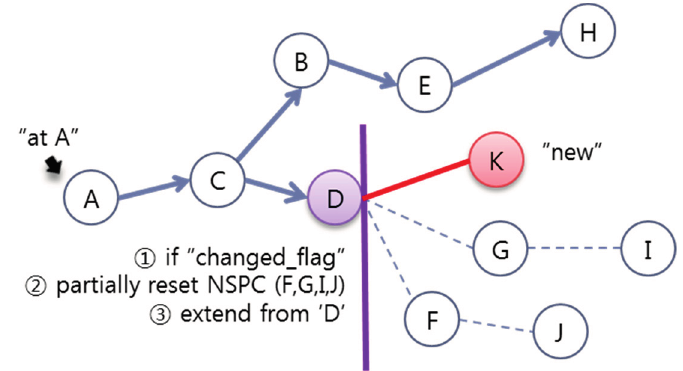
Figure 17. The procedure for changing the NSPC when there are changes at two-hop or more SLiM Hubs.